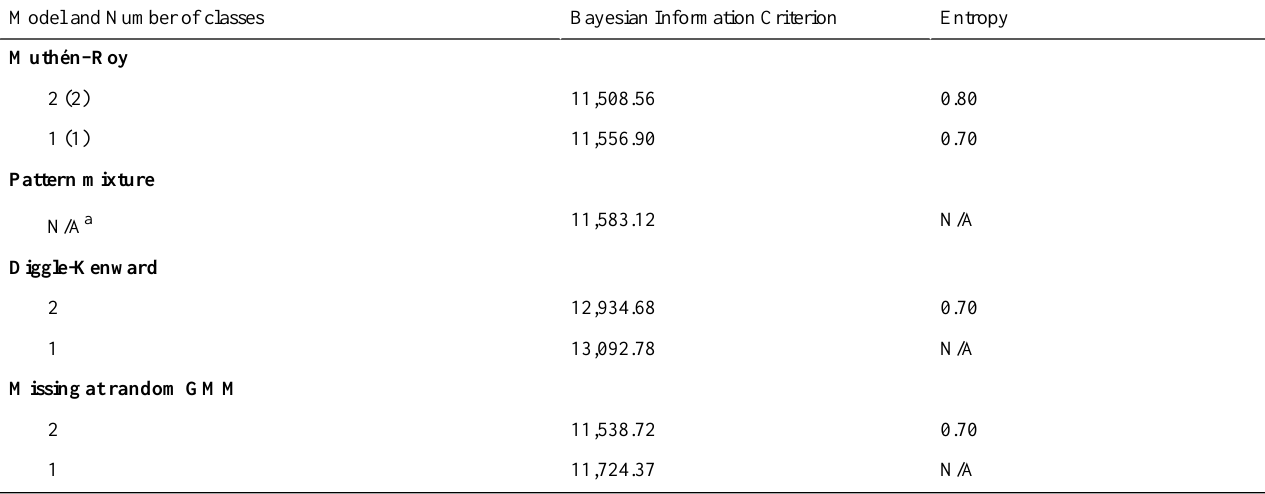
Table 2. Fit indices for Growth Mixture Models with increasing trajectory